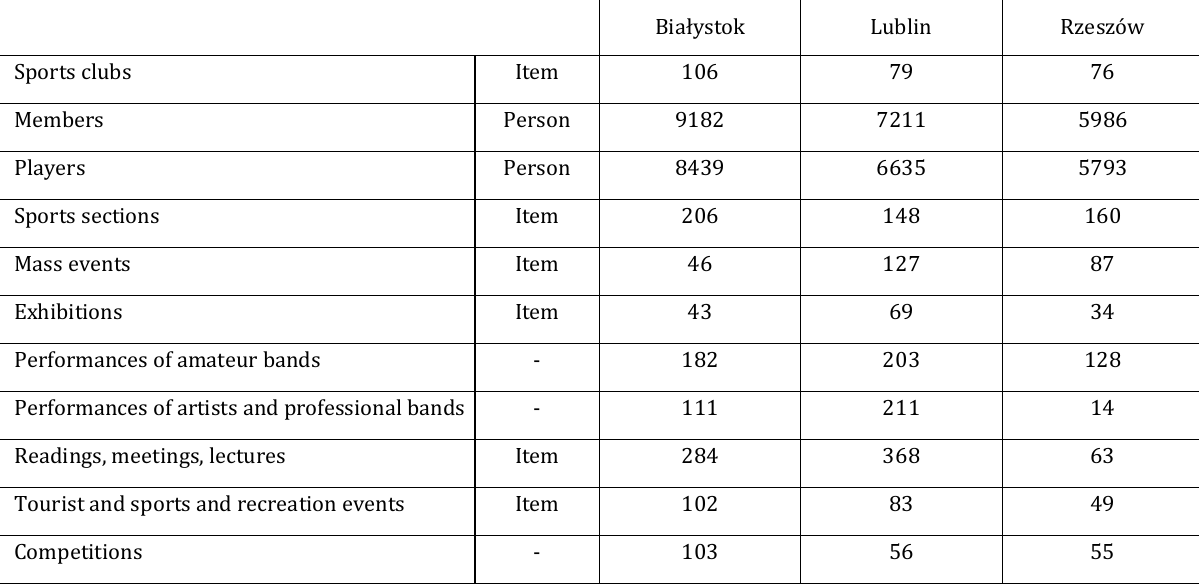
Table 6. Sports clubs and cultural events in Białystok, Lublin and Rzeszów